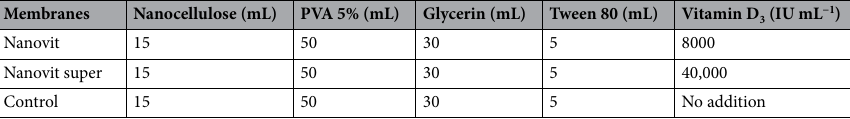
Table 1. Concentrations of vitamin D 3 in the